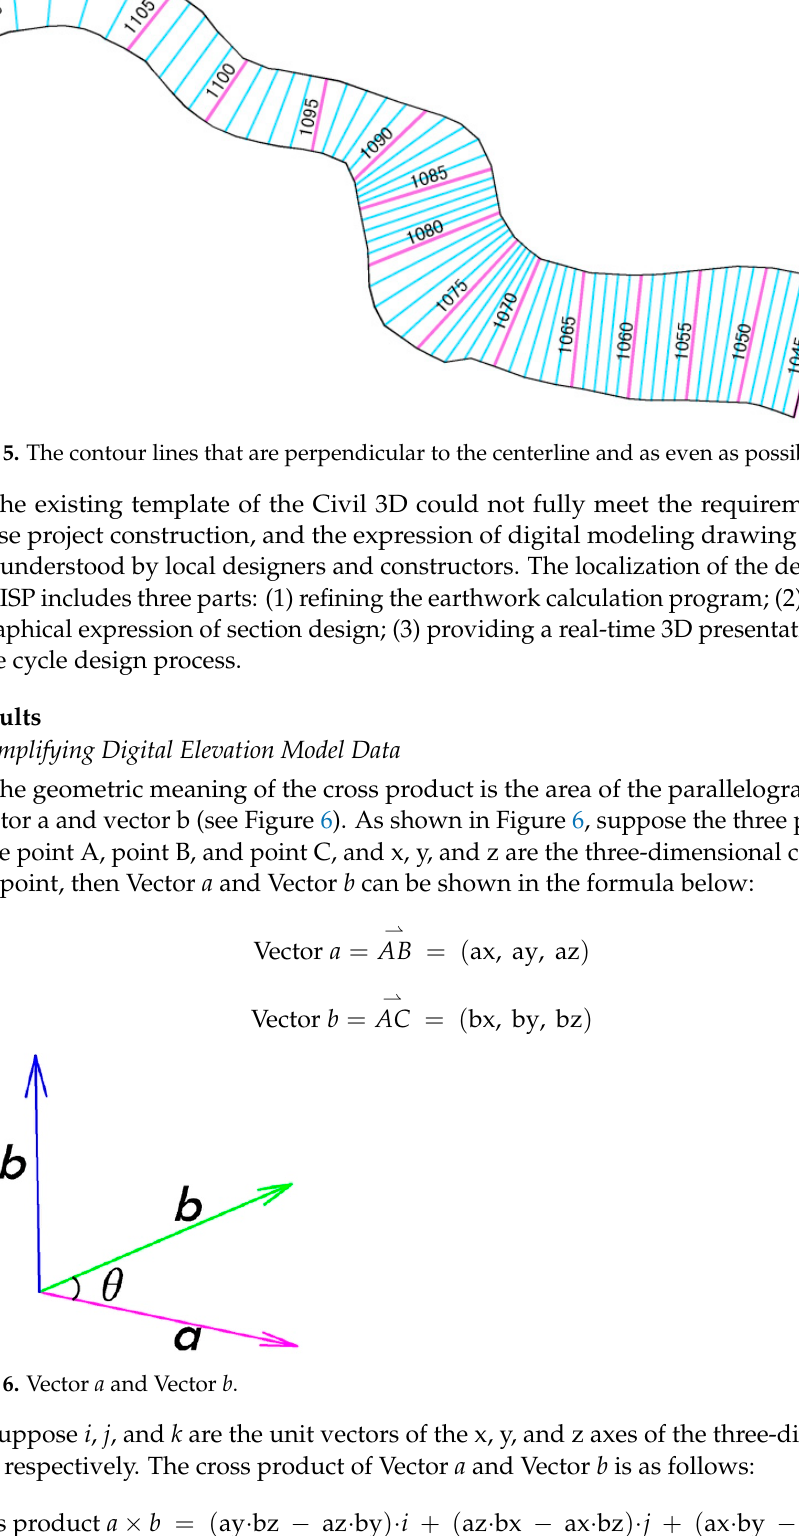
Figure 7. The selected contour line (marked as red in picture) of the digital model of the WTST. 4.2. Optimizing Ski Track Contour Lines 4.2.1. Setting the Point with a 1 m Contour Distance on the Centerline The centerline of the ski track should first be marked. The designers could try their best to use engineering curves, including straight lines and arcs, and fit the centerline